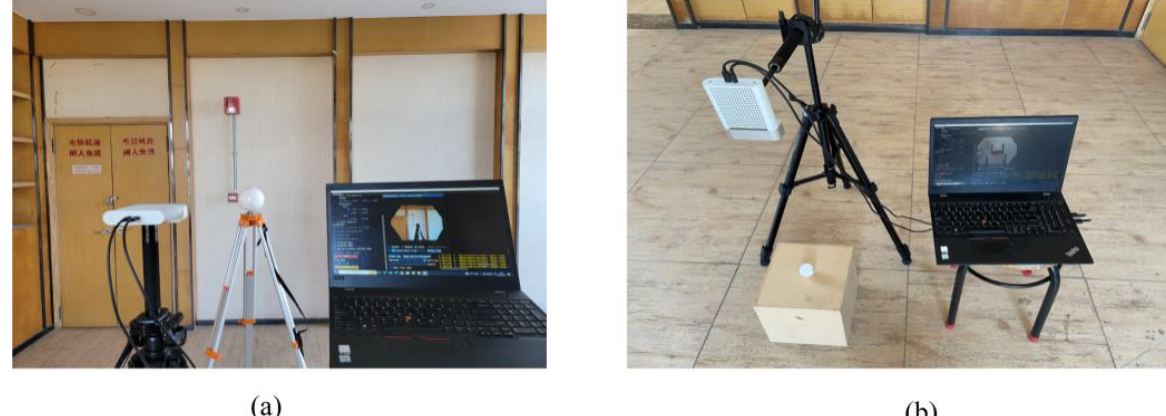
Figure 7. Preliminary experiments. (a) Measurement setup for temporal stability analysis; (b) The capturing distance